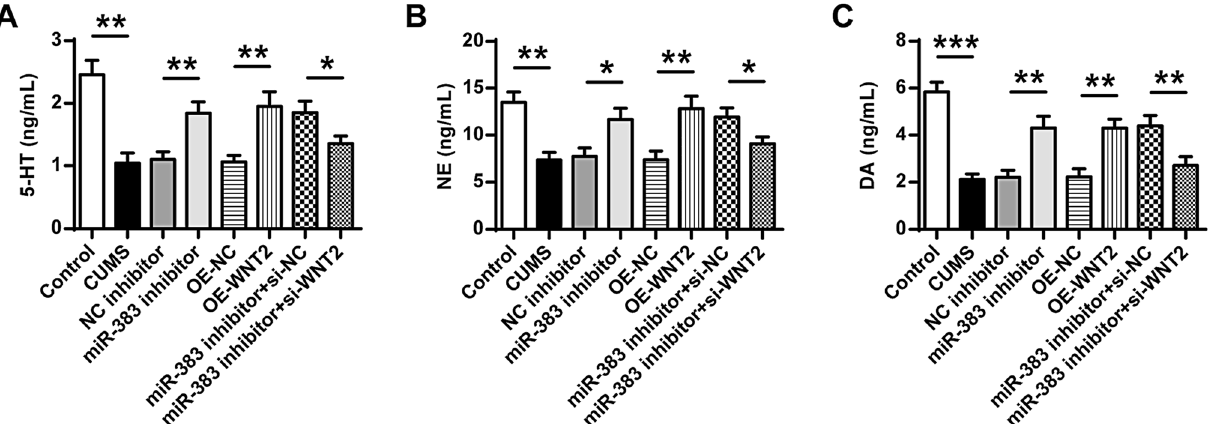
Figure 8. Downregulation of miR-383 or upregulation of Wnt2 increased the expression levels of neurotransmitters in CUMS-induced rats. The protein concentrations of serotonin (5-HT) ( A ), norepinephrine (NE) ( B ) and dopamine (DA) ( C ) in hippocampal tissues of rats in different groups were evaluated by ELISA assay. N = 6. Data were presented as mean ± SD and each experiment was repeated three times. * P < 0.05, ** P < 0.01, *** P <